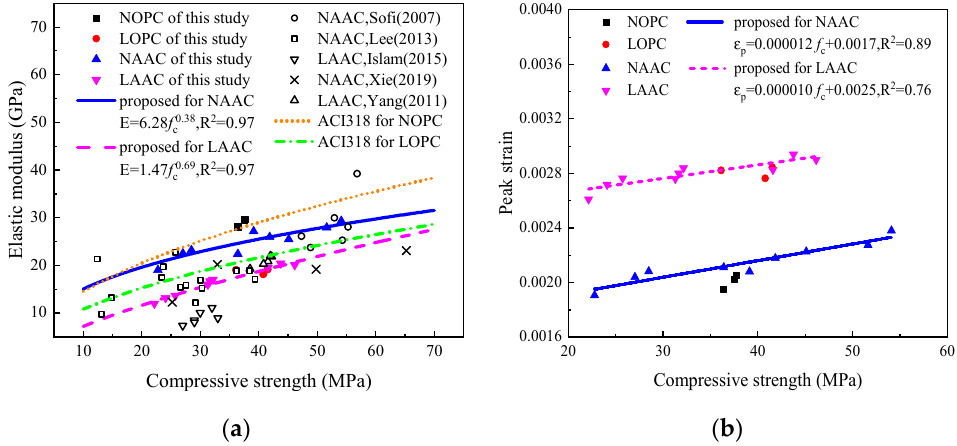
Figure 5. The mechanical properties of the AAC with different compressive strengths: ( a ) elastic modulus; ( b ) peak